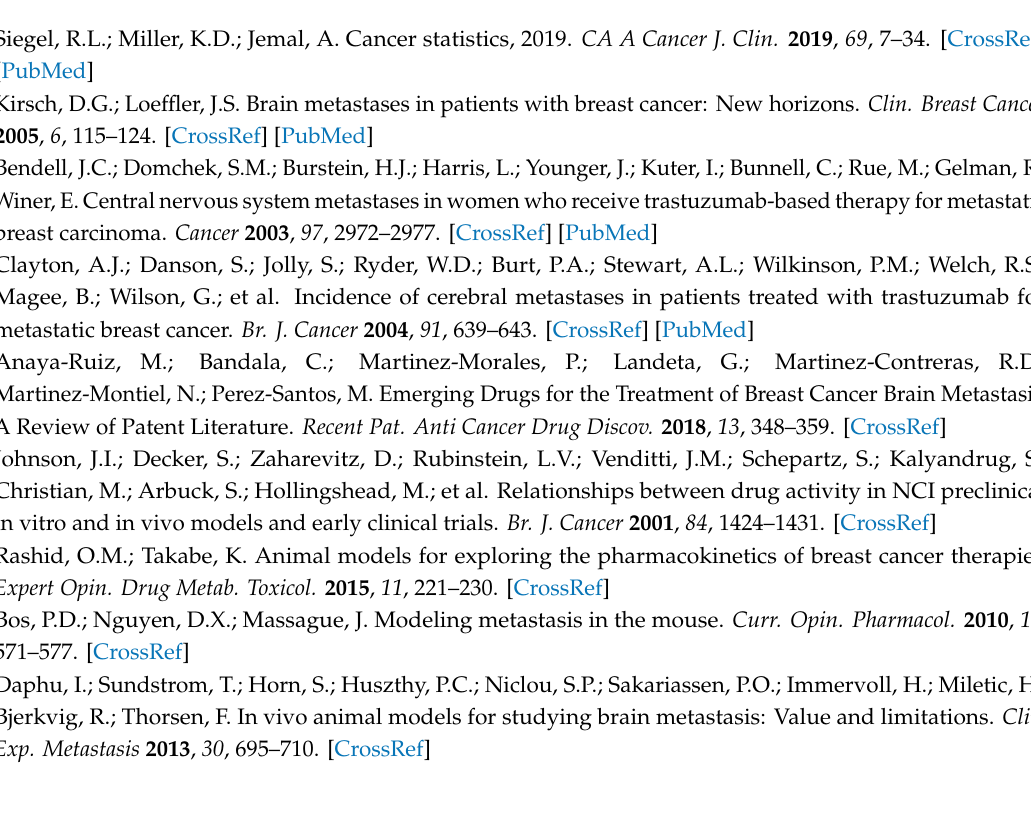
Figure S1: Survival of mice whose brains were implanted with brain metastasis of two breast cancer patients, Figure S2: Histology of breast cancer brain metastases grown as xenografts in mouse brain or mammary fat pad (MFP), Figure S3: Survival of mice whose brains were implanted with brain metastasis of two breast cancer patients, Table S1: Human breast cancer brain metastasis samples used in this study, Table S2: Gene expression data generated in this